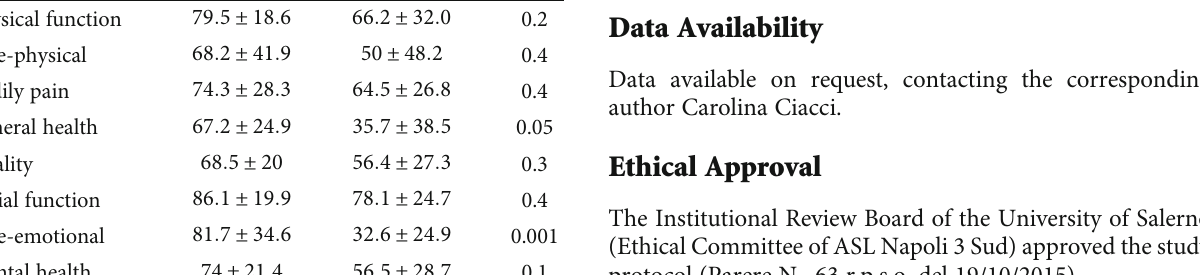
Table 4: The eight-item SF-36 scores in LT and KT patients 24 weeks (T24) after the end of DAA therapy. Data are expressed as mean ± standard deviation (SD). LT patients KT patients SF-36 components N = 17 N =